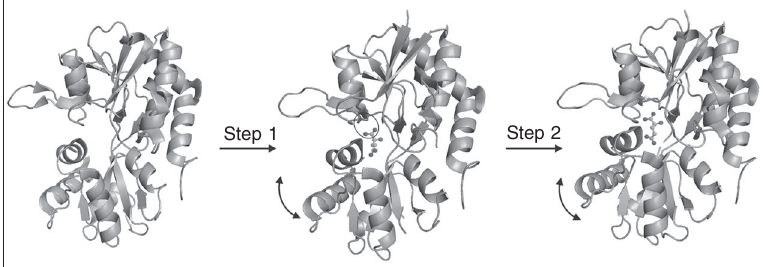
Figure 4. Schematic representation of the structural changes associated with the two-phase ligand-binding process for the GluR2-S1S2 domain binding to glutamate. Reproduced from Ref. 31 ( Nat Chem Biol 2005; 1: 329-332) with permission. Copyright 2005 Nature Publish- ing